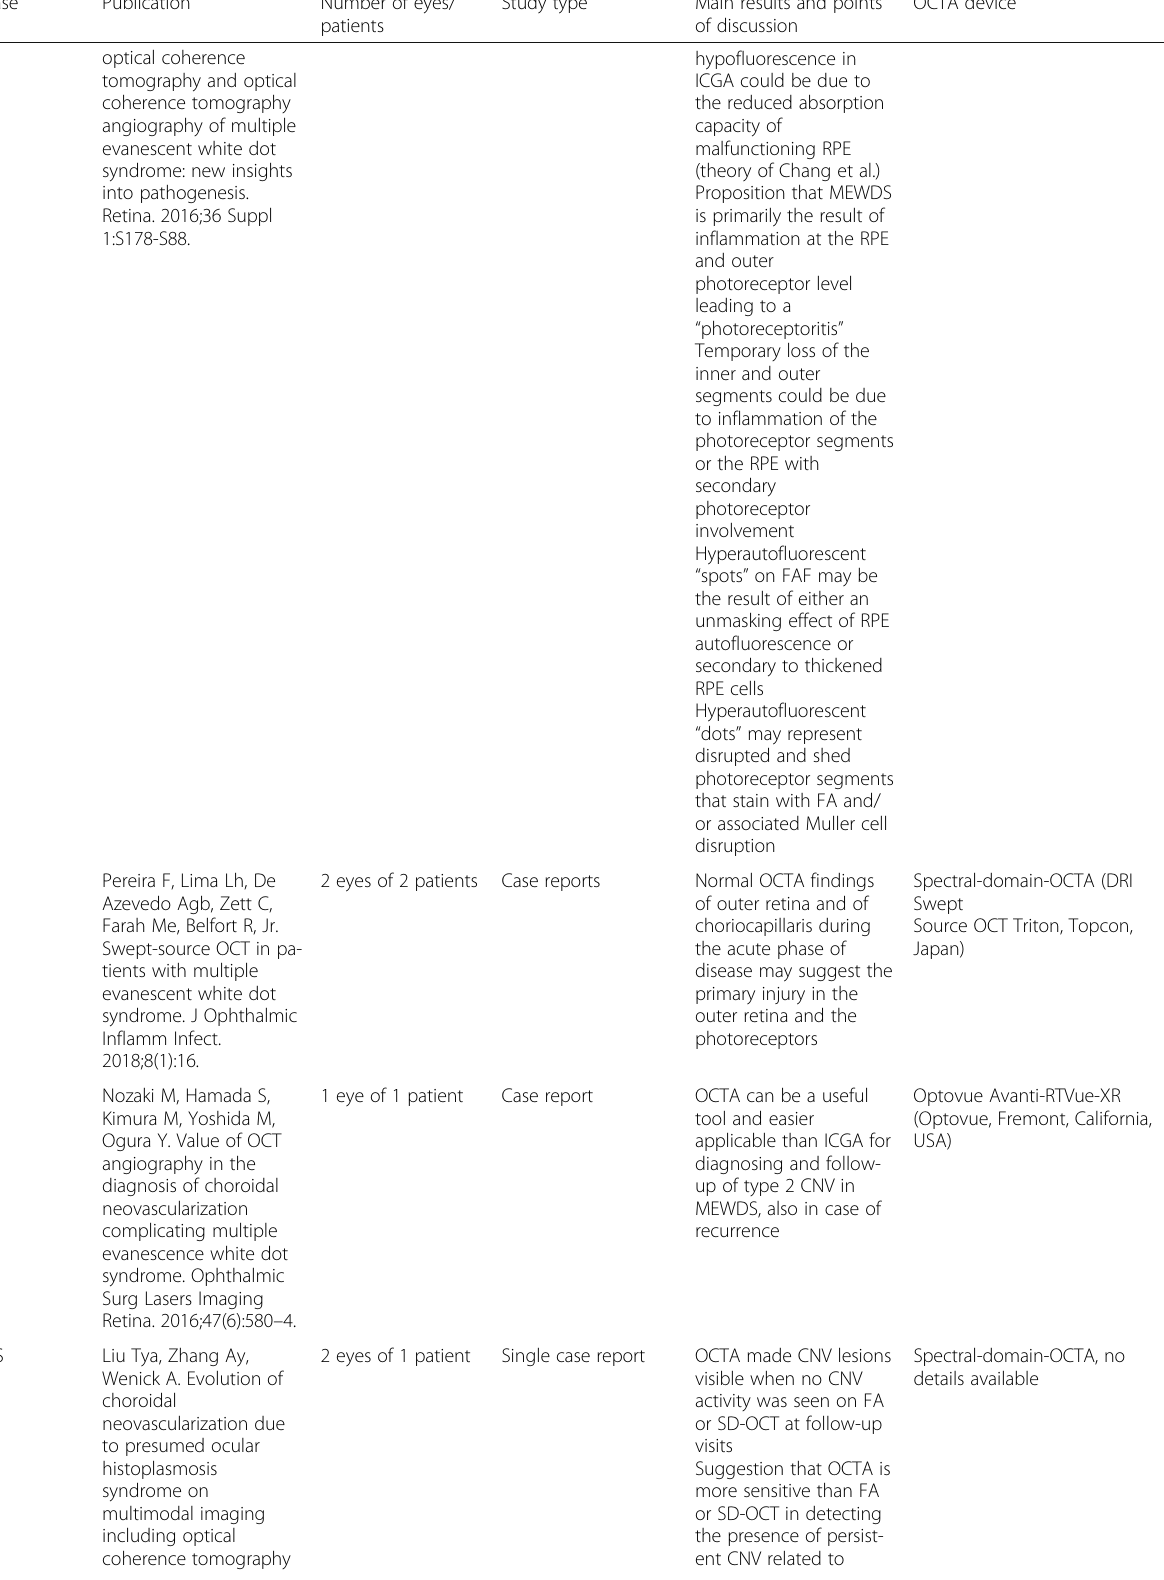
Table 1 Summary of publications on the implementation of OCTA in white dot syndromes (Continued)